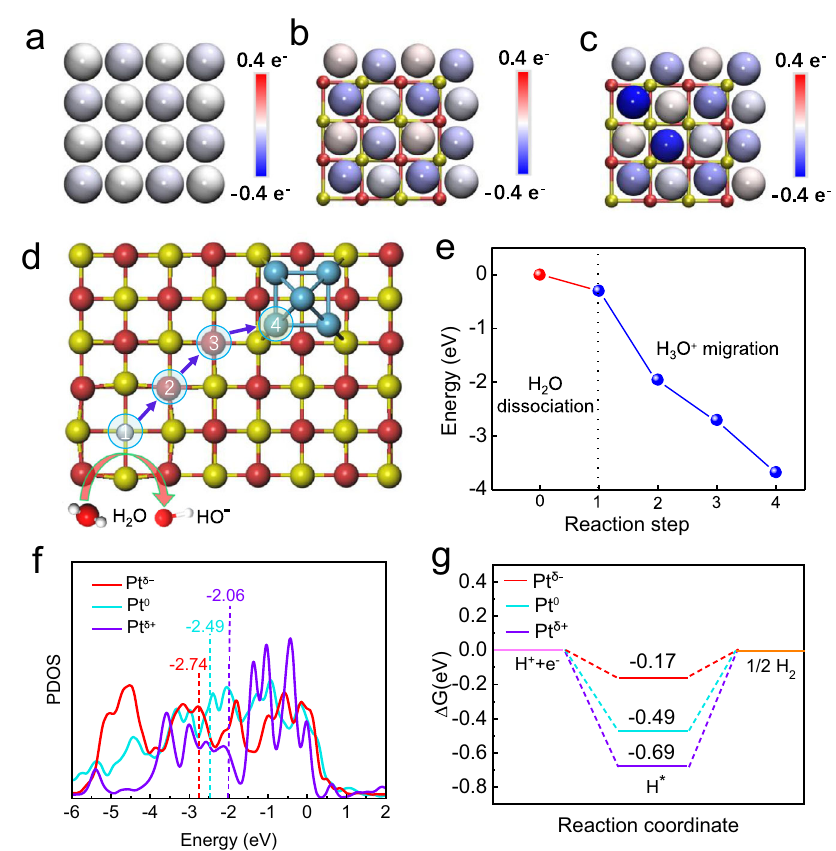
Fig. 4 Theoretical investigations. Atomic charge distribution of Pt ( a ), Pt-MgO ( b ), and Pt-MgO-Vo ( c ). The balls in red, yellow, and gray represent O, Mg, and Pt atoms, respectively. Schematic illustration ( d ) and energies resulting ( e ) from processes of adsorption of H 2 O followed by its dissociation and proton migration on the MgO (001) surface with anionic vacancies. f Calculated PDOS of the Pt d orbital of Pt δ − , Pt 0 , and Pt δ + . g Calculated adsorption energies of H on the surface of Pt δ − , Pt 0 , and Pt δ +